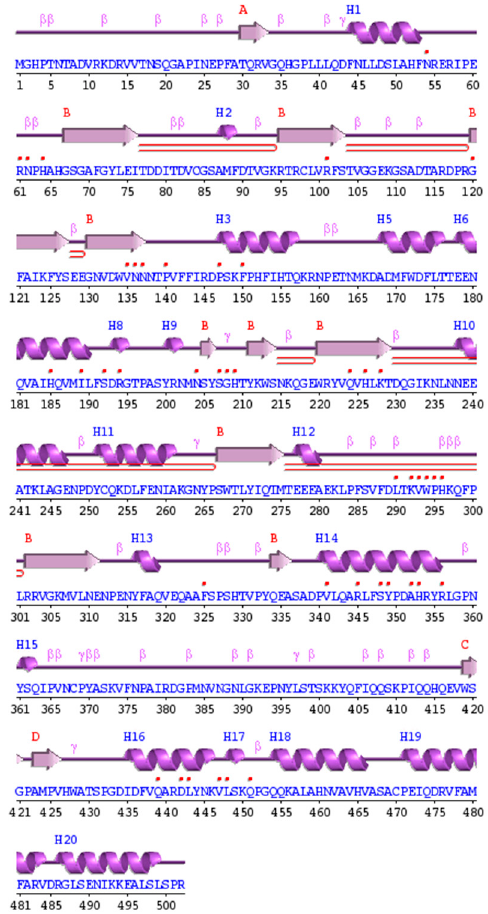
Figure 5. Wiring diagram of the predicted structure of S. schenckii catalase.